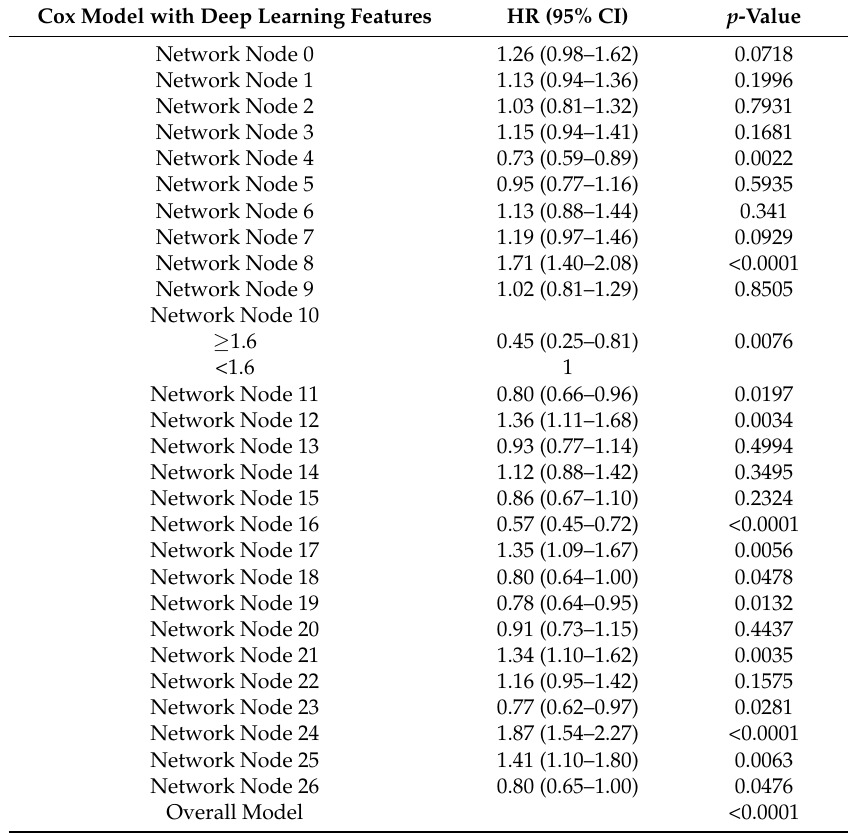
Table 2. The prognostic value of network node outputs at the top hidden layer are evaluated using Cox proportional hazard model. The hazard ratios (HR) and 95% confidence intervals (95% CI) are listed with corresponding p -value. Thirteen network nodes are statistically significant in overall survival